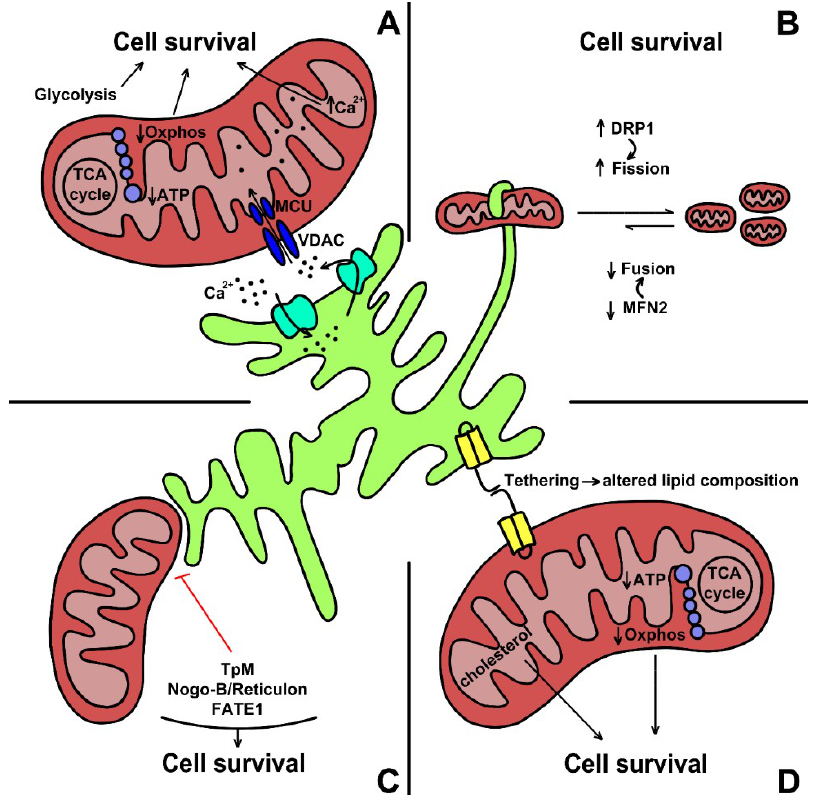
Figure 2. Main mechanisms involved in MAMs development and their role in tumor cell progression. ( A ). Calcium homeostasis is crucial to promote cell survival. A reduced flow of Ca 2+ into mitochondria blunts Oxphos activity, thus, reducing ATP production. Moreover, Ca 2+ induces the glycolytic pathway (Warburg effect), which eventually support cancer cells’ survival and proliferation. ( B ) Mitochondria fusion and fission programs are strictly controlled to be balanced in a physiological condition. However, during cancer progression, ER mediates mitochondria fission and shifts the equilibrium towards the fragmentation process. DRP1 and MFN2 are the main proteins involved in this context—the former enhances fission while the latter regulates mitochondrial fusion. ( C ) Tumor cells’ survival depends on the ER–mitochondria distance. Apoptosis happens as a consequence of their proximity, while a greater distance is associated with cell survival, as shown for Tpm, Nogo-B / Reticulon, and FATE1 proteins. ( D ) ER–mitochondrion tethering alters mitochondrial lipid composition. Specifically, their binding increases cholesterol levels, boosting up aerobic glycolysis and reducing Oxphos activity.